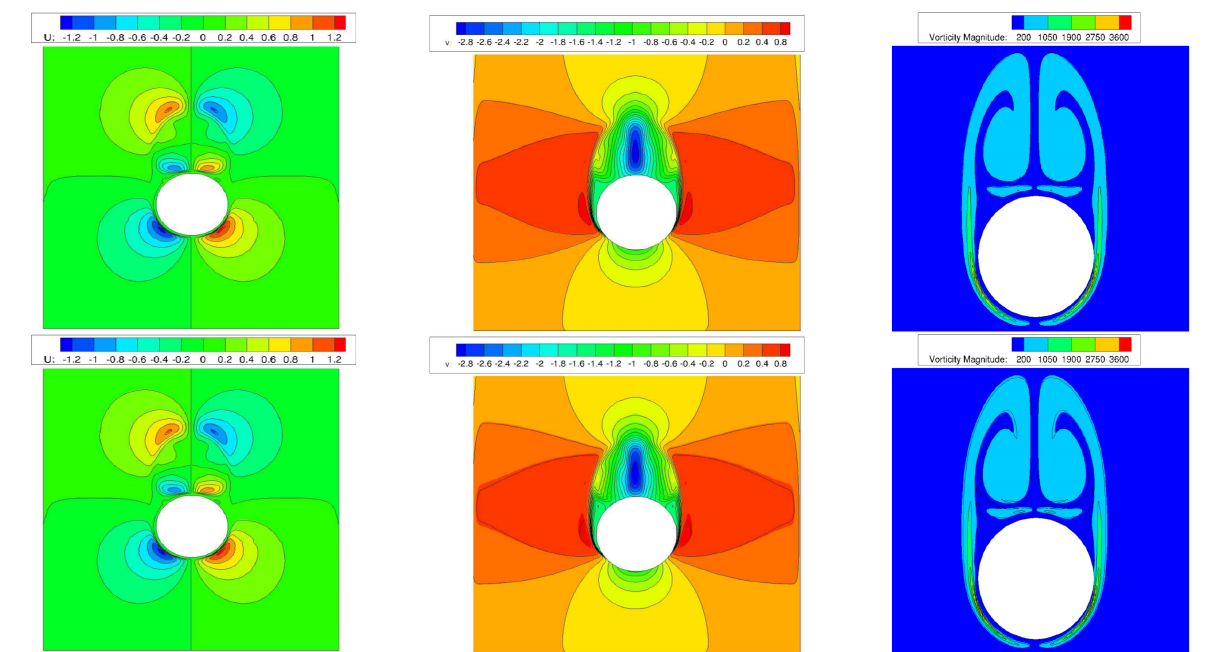
Figure 2. Free fall of dense cylinder at t = 0.144 s, obtained on a fine mesh 400 × 800 by the three methods. In the first row, FC (shown by fields) and AAL (by isolines). In the second row, FC (shown by fields) and SP (by isolines with ∆ t = 6.25 × 10 − 6 s). The different fields presented in each row are: left horizontal velocity [ 0 m,0.1 m ] × [ 0 m,0.11 m ] , middle: vertical velocity [ 0 m,0.1 m ] × [ 0 m,0.10 m ] , and right: vorticity magnitude [ 0.02 m,0.08 m ] × [ 0.034 m,0.089 m ] .